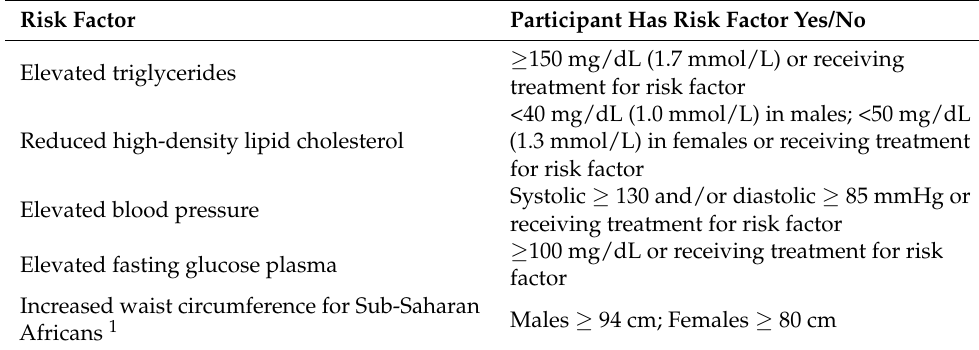
≥ 150 mg/dL (1.7 mmol/L) or receiving treatment for risk factor for risk factor Systolic ≥ 130 and/or diastolic ≥ 85 mmHg or receiving treatment for risk factor ≥ 100 mg/dL or receiving treatment for risk factor